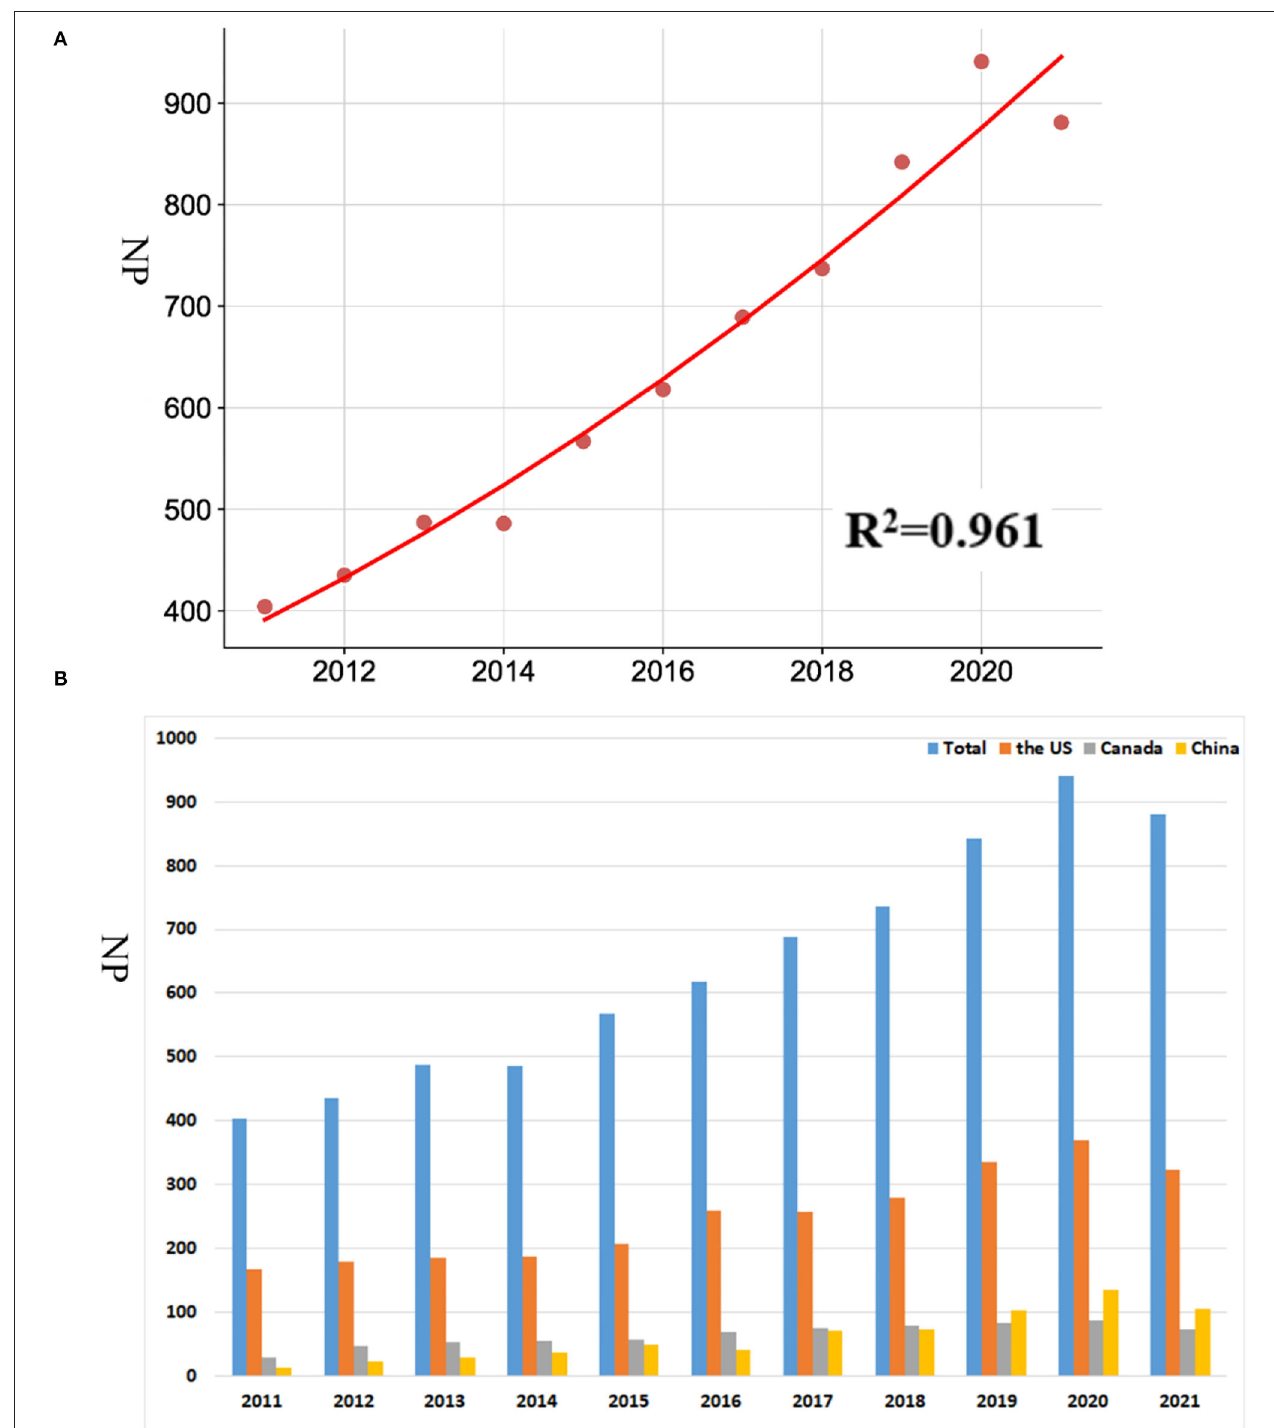
FIGURE 2 | (A) Curve fitting of the total annual growth trend of publications. (B) Number of publications by year from 2011 to 2021.